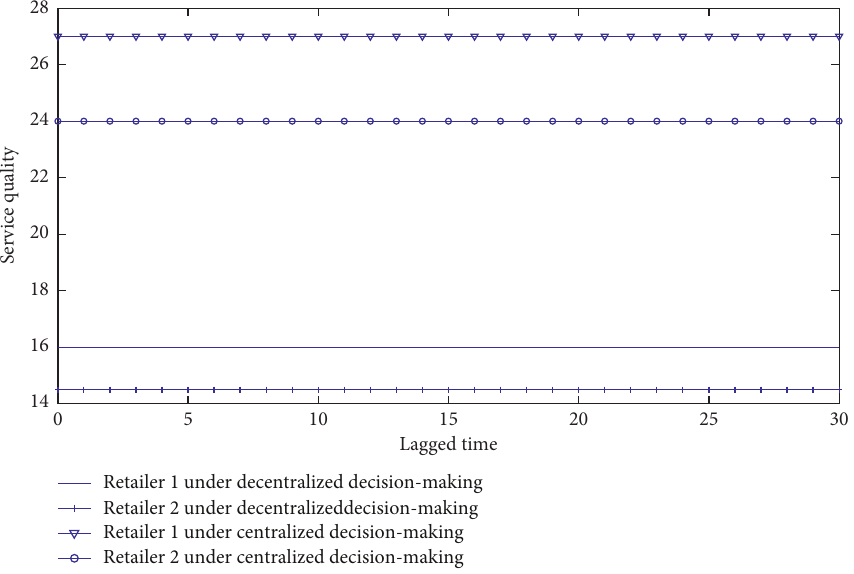
Figure 3: Comparison of the retailers’ service quality level under the two decision-making